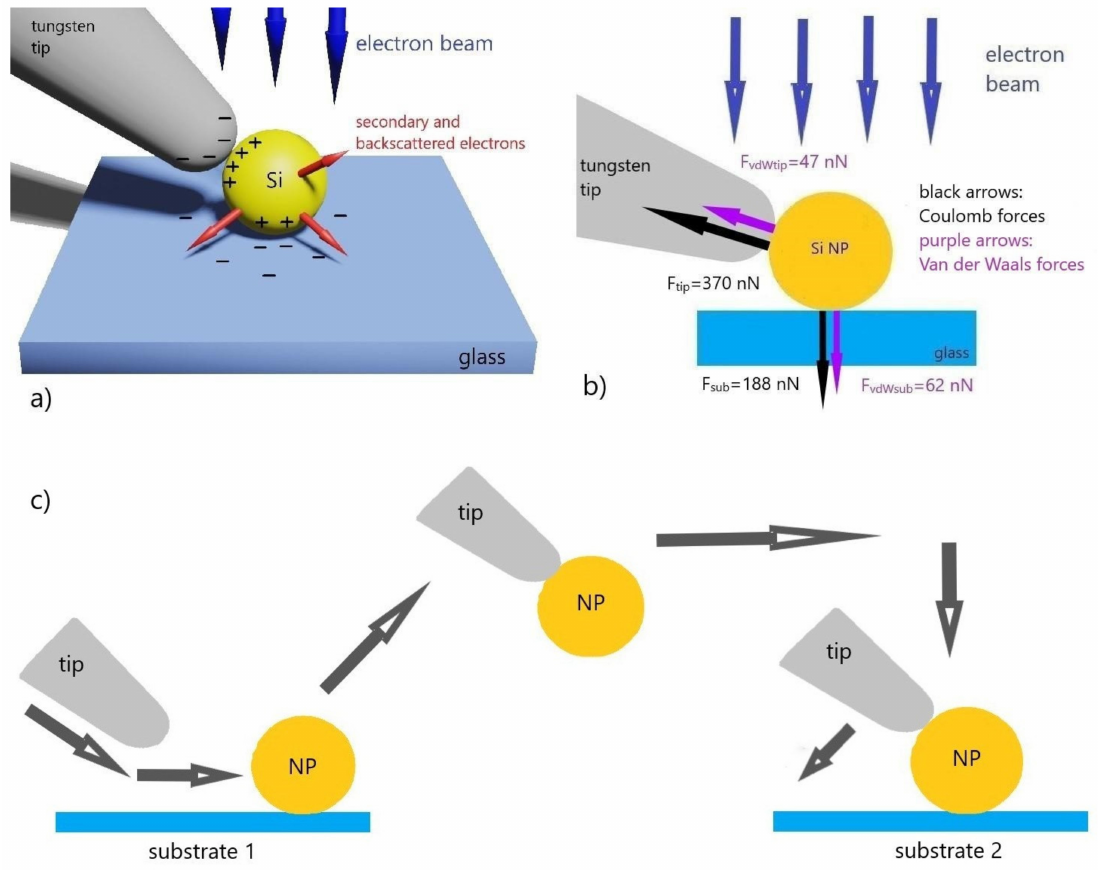
Figure 2. ( a ) The mechanism of charging by a scanning electron beam. The substrate is negatively charged by the primary electron beam while, due to the spherical shape, the nanoparticle is positively charged. At the particle-substrate interface a double electric layer is formed, meanwhile an ungrounded metal tip is negatively charged by the primary electron beam. When the tip touches the positively charged particle, a double electric layer with a higher capacitance, compared to the particle-substrate interface, is formed; ( b ) Diagram of forces acting on a nanoparticle at particle-substrate and tip-particle interfaces; ( c ) The scheme of the particle retrieval at the manipulator tip, moving to the other substrate, and subsequent release. The grey arrows depict the direction of tip